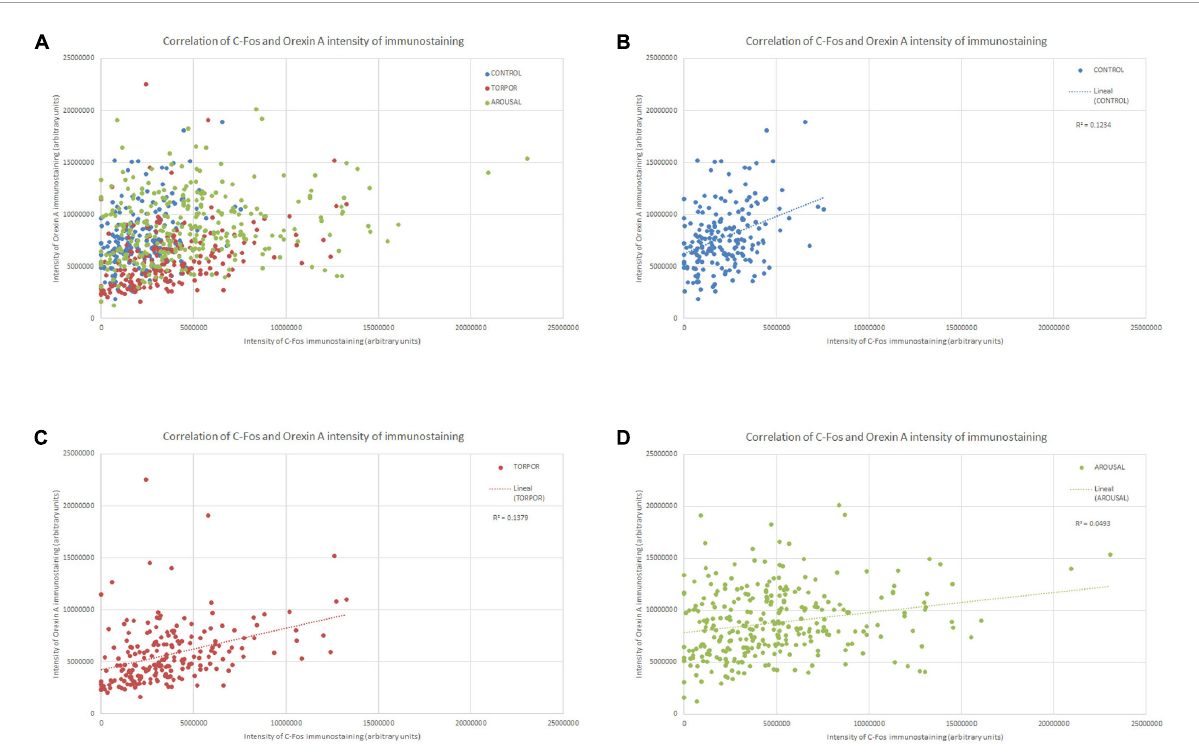
FIGURE7 Diagrams showing the correlation between the intensity of C-Fos (X axis) and OXA (Y axis) immunostainings of all orexinergic neurons analyzed (A) and those analyzed from hamsters at euthermia (B) , torpor (C) , and arousal (D) . See Table 1 for R, R2, and p -values.